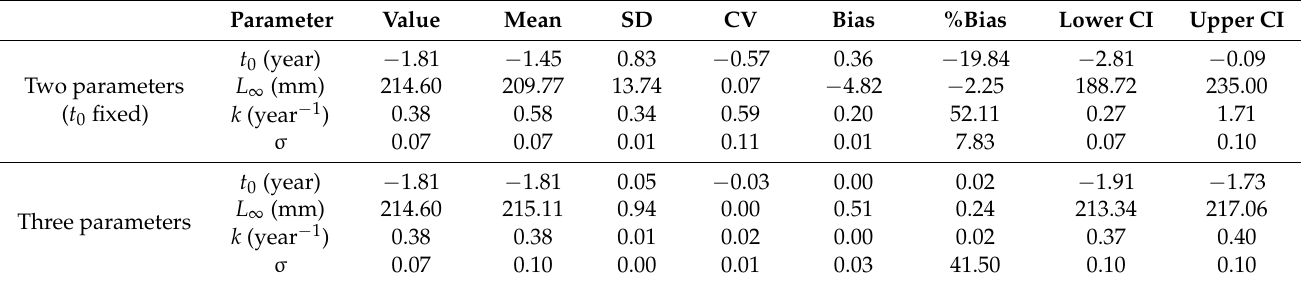
Table 8. Parameters and bias-corrected percentile confidence intervals (CI; α = 0.05) from von Bertalanffy model (VBM) for the temperate Sardinops sagax stock in the southern California Current System